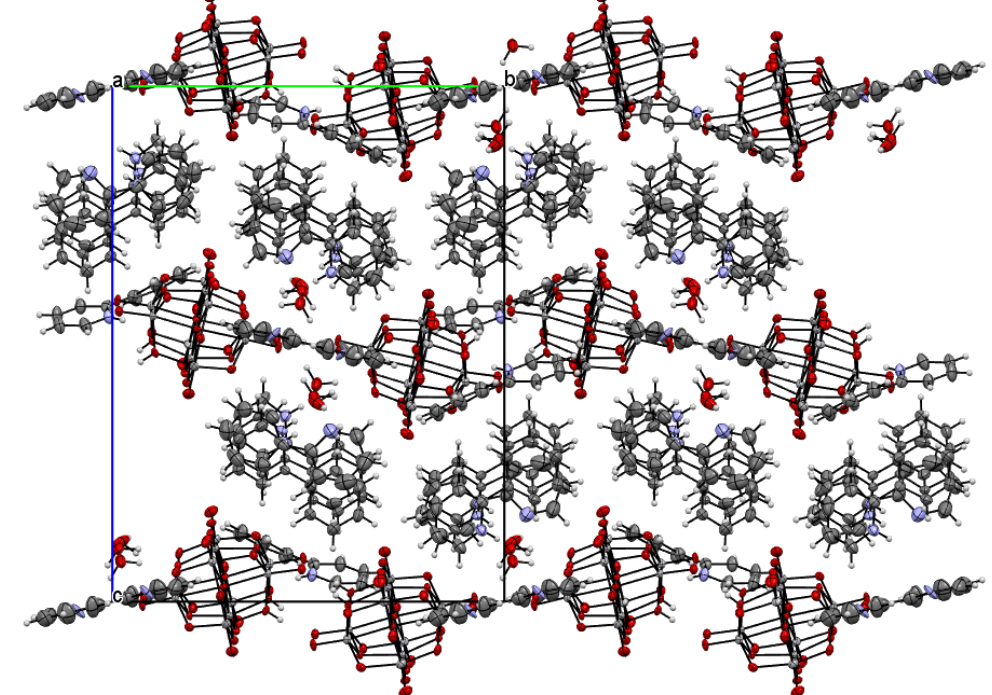
Figure 3. Crystal packing of title compound viewed along the a -axis. Table 1. Crystal data and structure refinement for the title compound.